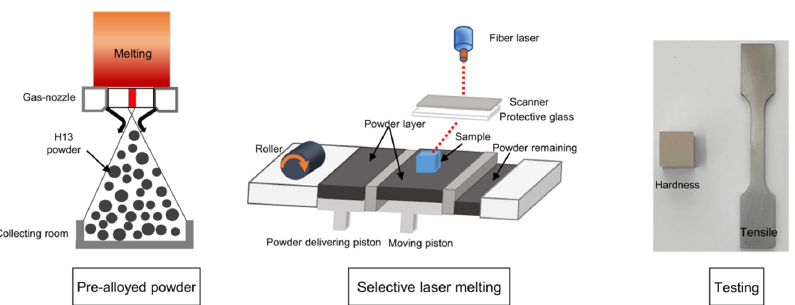
Figure 3. Schematic diagram showing the experimental procedures of H13 steel, including powder preparation, selective laser melting and the geometry of testing samples. preparation, selective laser melting and the geometry of testing